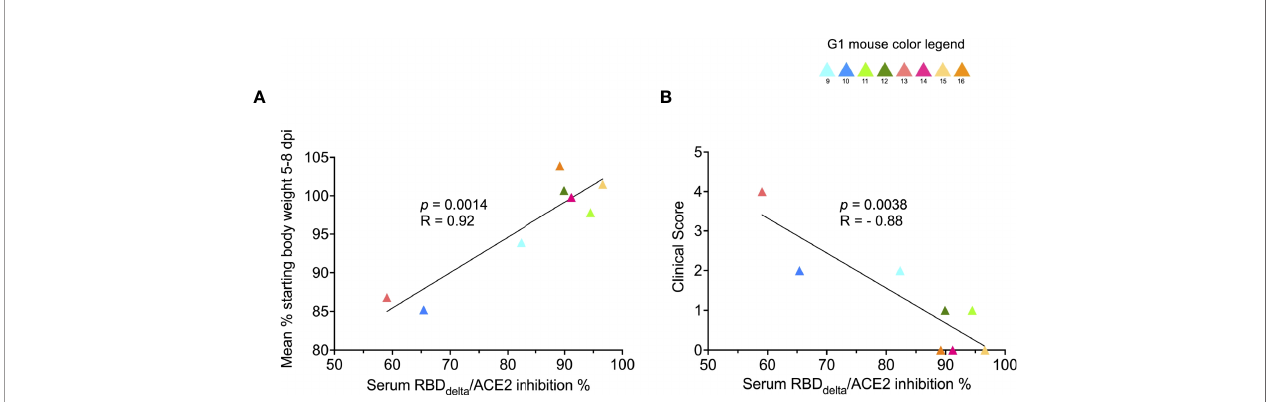
FIGURE 11 | Protection against COVID-19 disease correlates with RBD Delta -ACE2 interaction inhibition by neutralizing antibodies: Correlation between SARS-CoV-2 neutralization antibody assay results and clinical results was assessed in infected K18-hACE2 transgenic mice of immunized Group 1 followed until 14 dpi (n= 8 with individual color code). (A) Simple linear regression between RBD Delta -ACE2 interaction inhibition rate at week 8 and body weight variation between day 0 and mean of body weights during acute disease period (5-8 dpi). Correlation is signi fi cant ( p -value= 0.0014, R= 0.92). (B) Simple linear regression between RBD Delta -ACE2 interaction inhibition rate at week 8 and highest reached clinical score. Correlation is signi fi cant ( p -value= 0.0038, R=